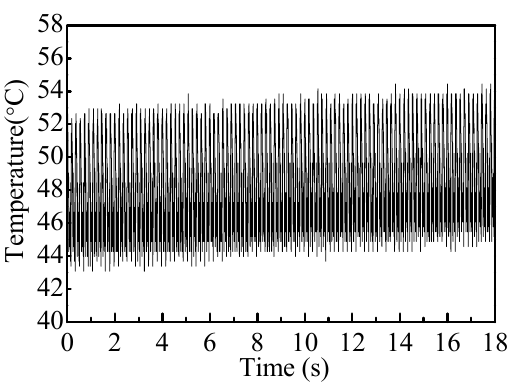
Figure 26. Effect of linear error calibration.